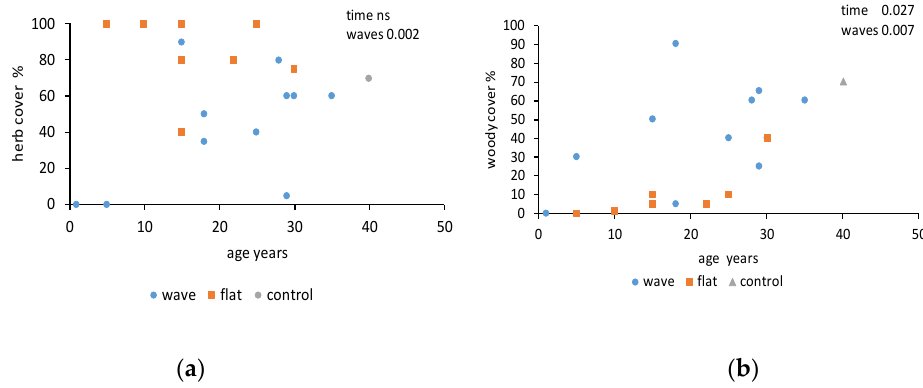
Figure 2. ( a ) Herb and ( b ) woody cover in postmining sites of various ages that were either levelled (flat) or not (wave). Control was forest unaffected by mining; p values shown for effect of plot age (time) and presence of wavy surfaces (waves).